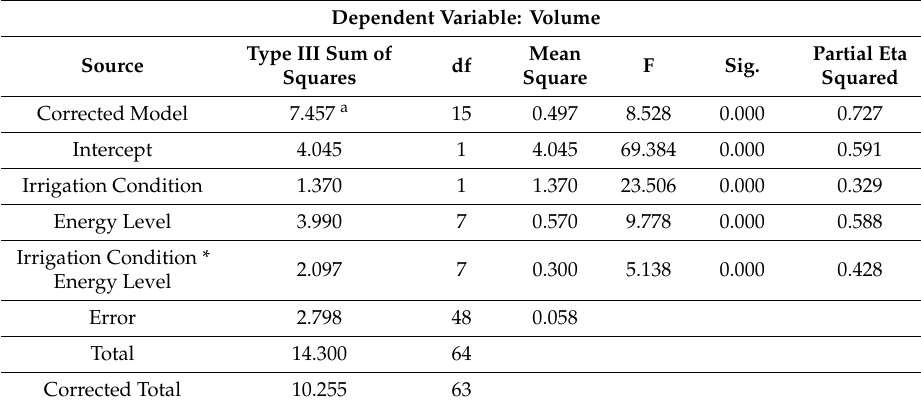
Table A1. Tests of Between-Subjects E ff ects.